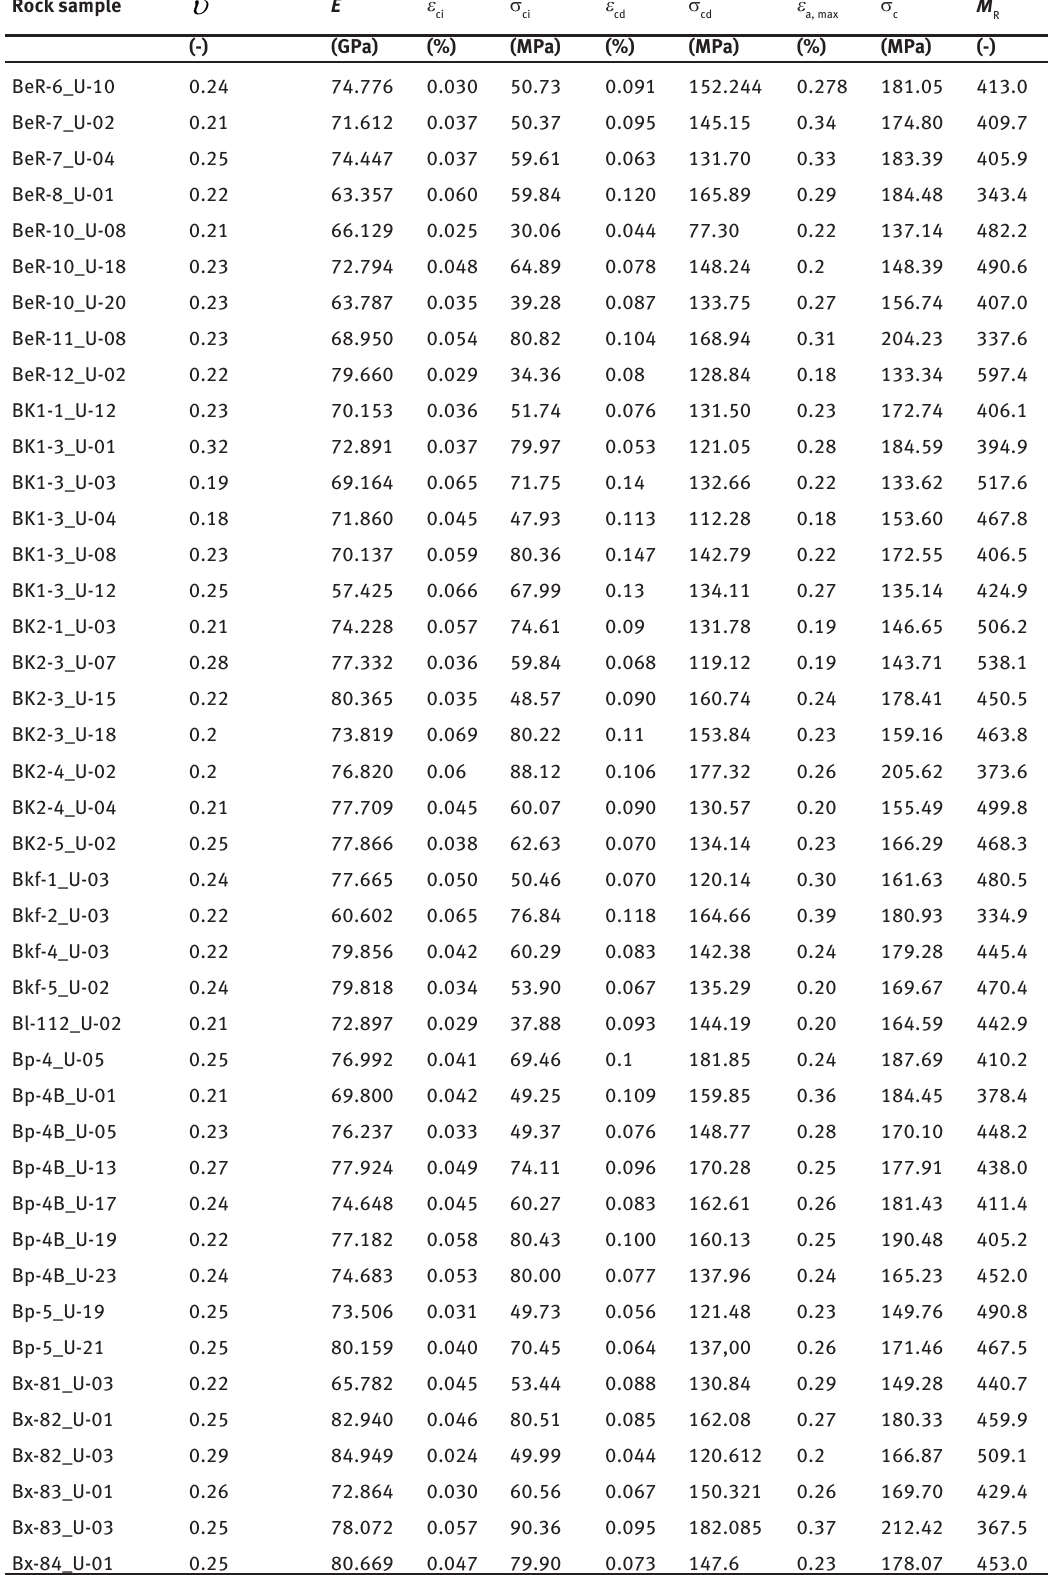
Table 1: Mechanical properties of investigated Mórágy granitic rock samples. Rock